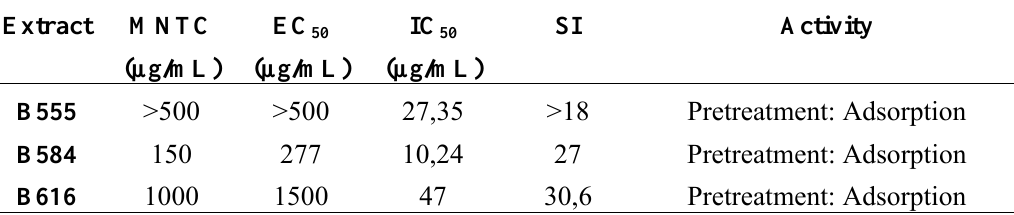
Table 2. Promising and active